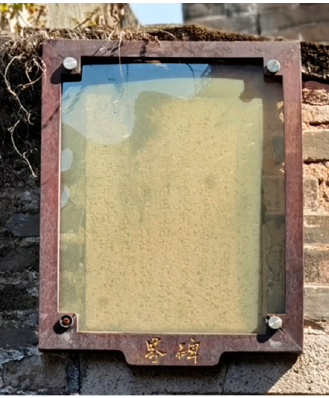
Figure 20. Front of the boundary monument. (Source: the authors).